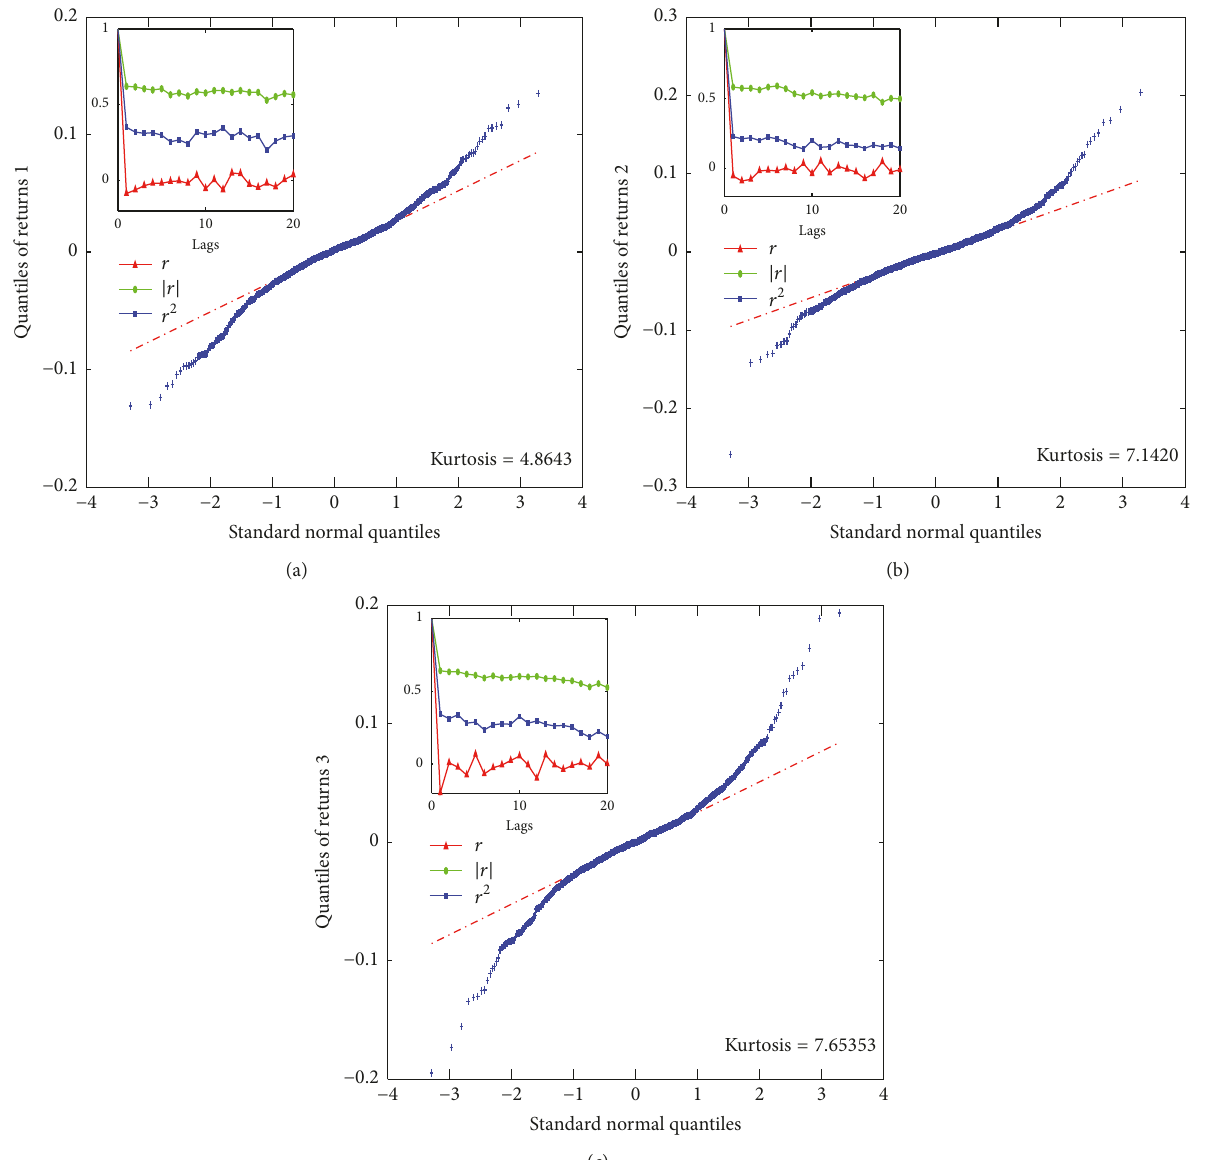
Figure 3: Q-Q plots about returns of stock prices and autocorrelation diagrams of raw, absolute, and squared returns.